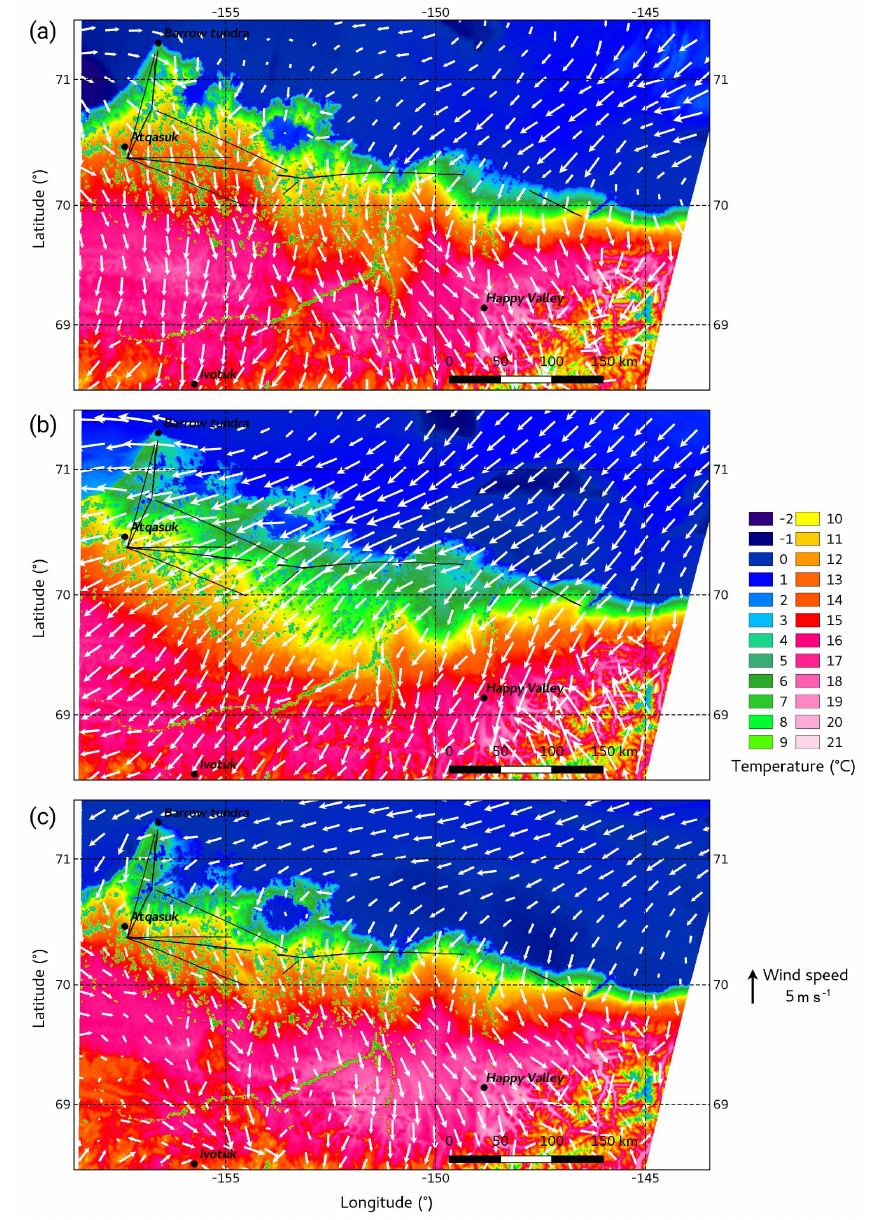
Figure 3. Air temperature at 2m above the ground and wind speed at 10m above the ground, simulated by the WRF model for 28 June at 14:00hLT (a) , for 29 June at 12:00hLT (b) , and for 30 June at 12:00hLT (c) . Black lines represent Polar 5 flight